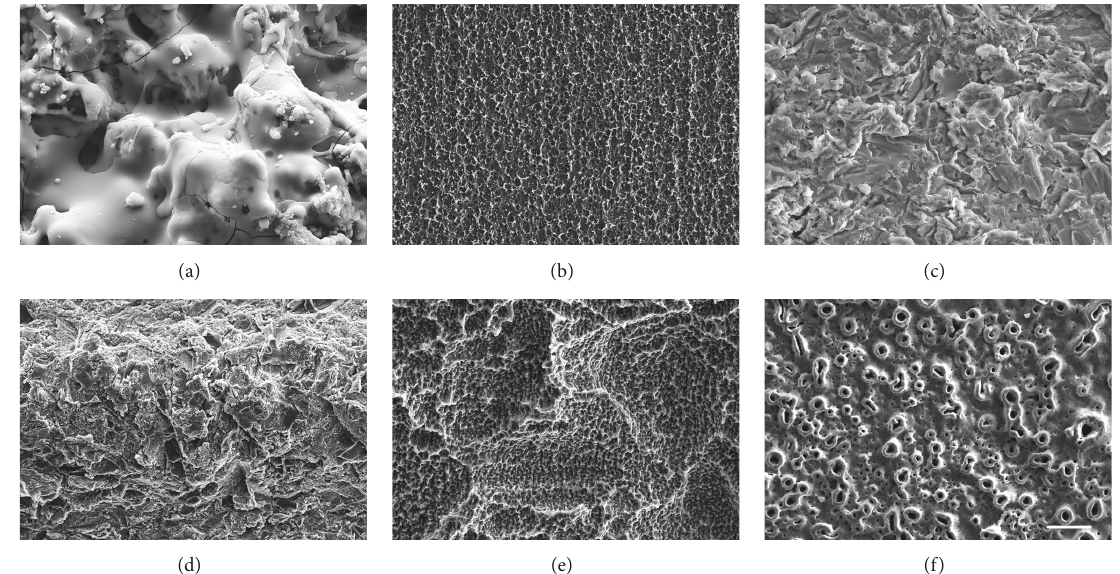
Figure 8: SEM micrographs of different moderately rough implant surfaces in the market: (a) hydroxyapatite coated, (b) acid etched, (c) Ca 3 (PO 4 ) 2 blasted, (d) TiO 2 blasted, (e) sandblasted and acid-etched, and (f) anodized. Scale bar: 20 𝜇 m.